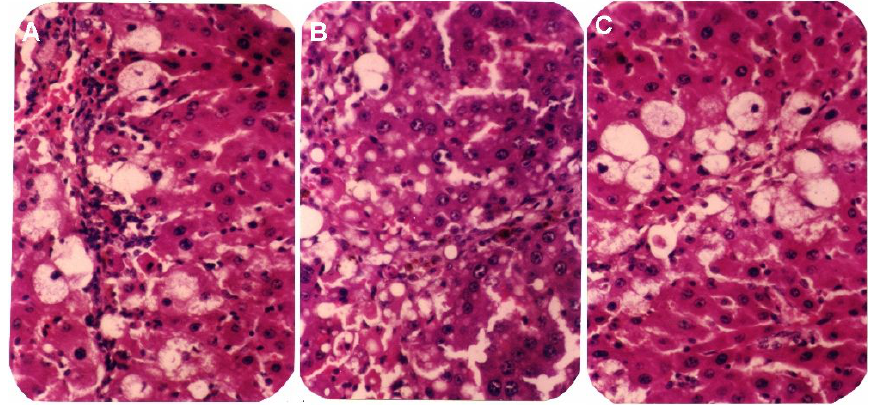
FIGURE 2. Section of liver from (A) CCl 4 and biphenyldimethyldicarboxylate (DDB) (75 mg/kg)-treated rat showing mild fibrosis, vacuolar degeneration, some pyknotic nuclei, karyolysis and karyorrhexis; (B) CCl 4 and biphenyldimethyldicarboxylate (DDB) (375 mg/kg)-treated rat showing minimal fibrosis, macro and micovacuolar degeneration, some pyknotic nuclei and karyolysis; (C) CCl 4 and DDB (75 mg/kg) + silymarin (22 mg/kg)-treated rat showing vacuolar degeneration, signs of degeneration in the form of pyknosis, karyolysis and hypertrophy of Kupffer cells (H & E x 200).